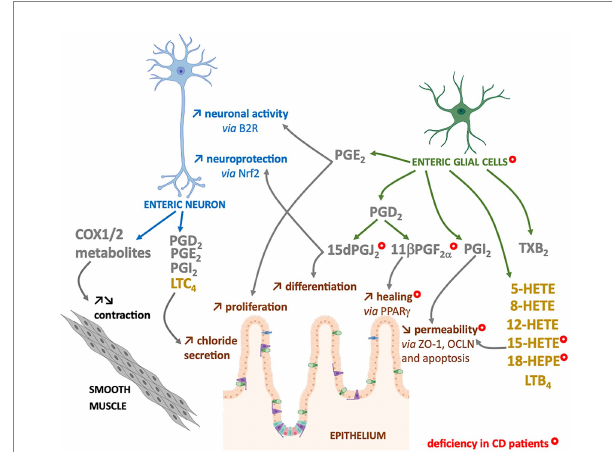
FIGURE 3 Enteric neurons and glial cells produce n-6 oxylipins to regulate the neighboring cells. Some n-6 oxylipin are to regulate glia or neurons, but also to control functions of smooth muscle or intestinal epithelial cells. COX-(grey) or LOX-(yellow) derived n-6 oxylipins produced by enteric neurons and/or glial cells can regulate different enteric neuron properties (blue), but also intestinal epithelial barrier properties (brown) or smooth muscle contraction (black). Marked with a ( ) are cells, oxylipins or cellular functions deficient in chronic inflammatory disease that is Crohn’s disease